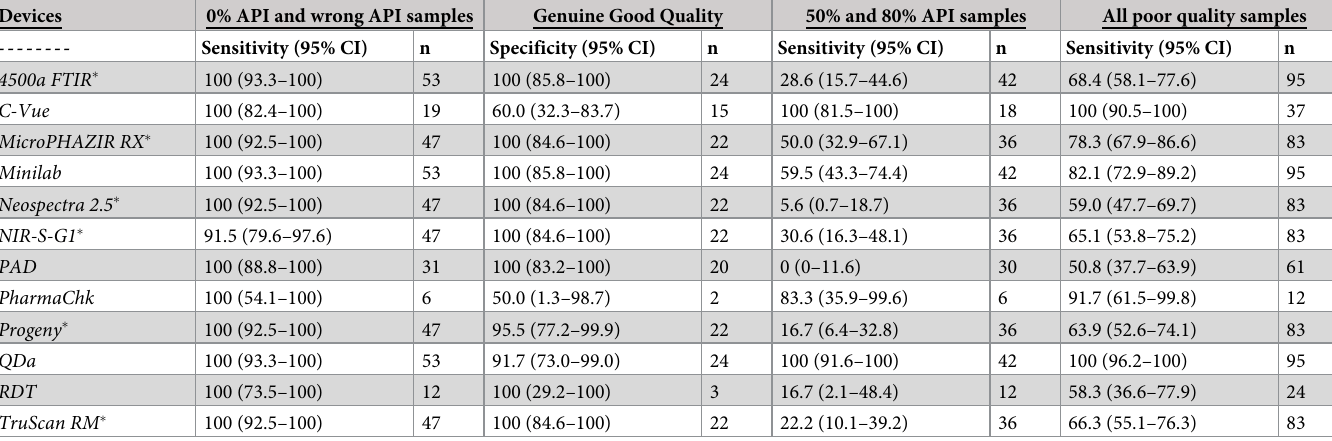
Table 2. Sensitivity and specificity to correctly determine quality of medicine samples for the 12 tested